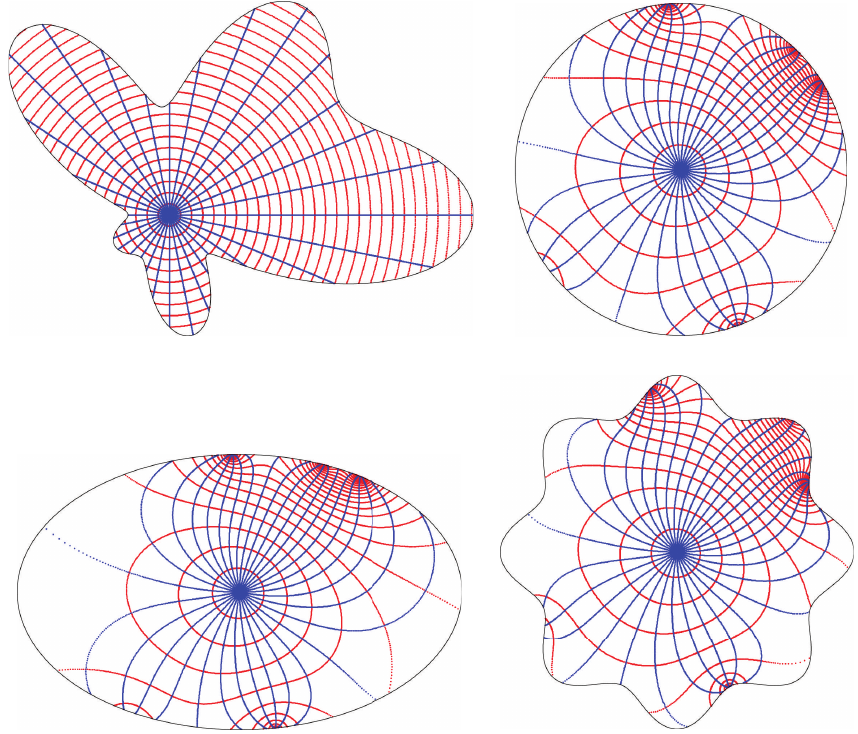
Figure 3: The conformal mappings from 𝐺 3 onto Ω 1 , Ω 2 , and Ω 3